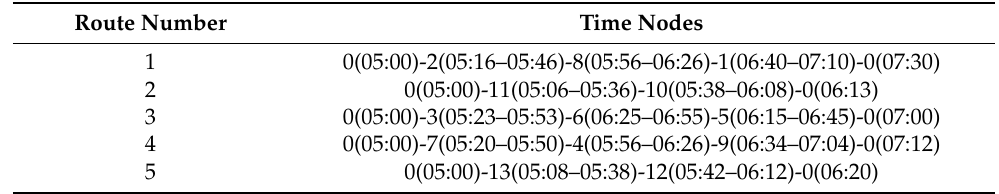
Table 15. The optimized vehicle travel time node.